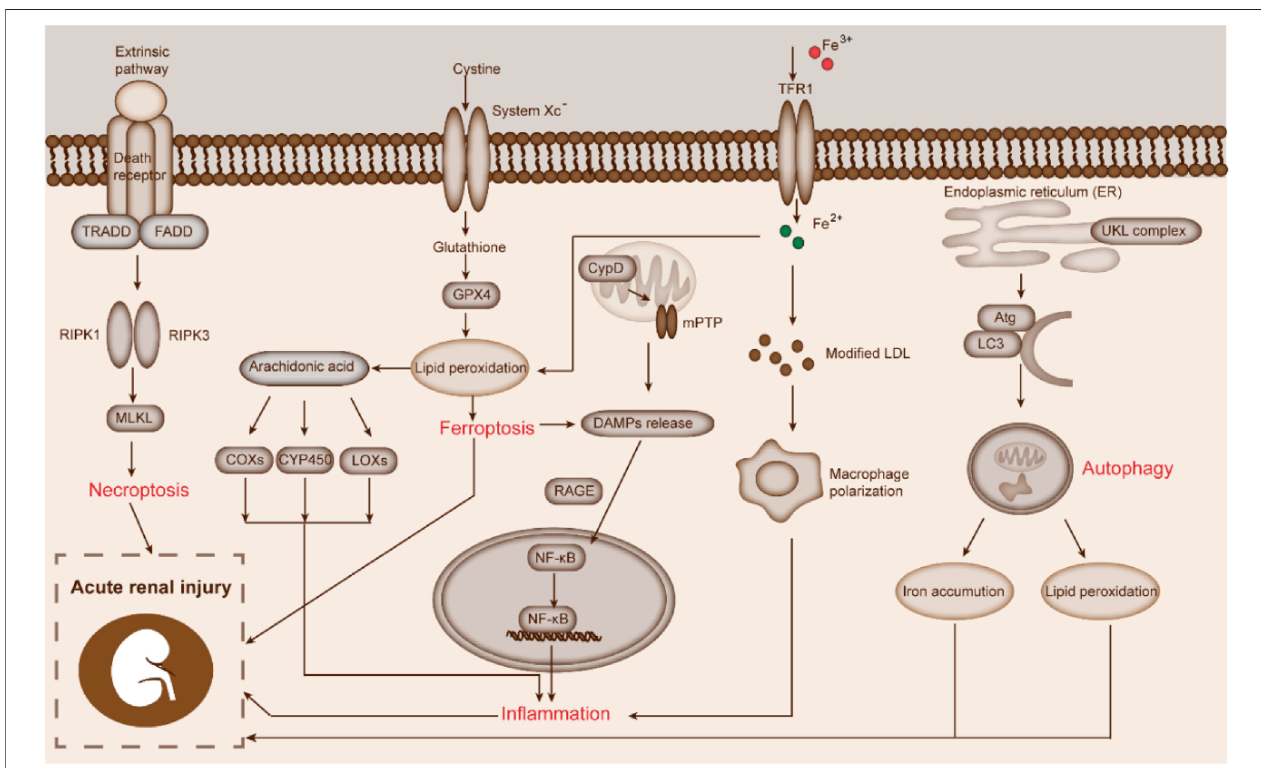
FIGURE 3 | Biological responses correlated to ferroptosis during AKI. This fi gure displays the crosstalk between necroptosis, in fl ammation, autophagy, and ferroptosis in AKI.